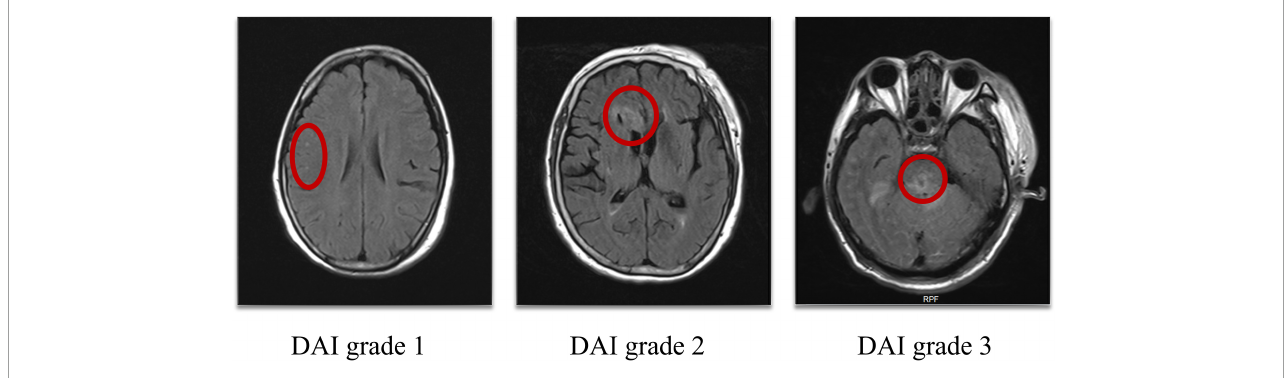
FIGURE1 DAI grade 1: Lesions in the hemispheres, DAI grade 2: Lesions in the corpus callosum, DAI grade 3: Lesions in the brainstem (as shown in the red circle). DAI, Diffuse axonal injury.